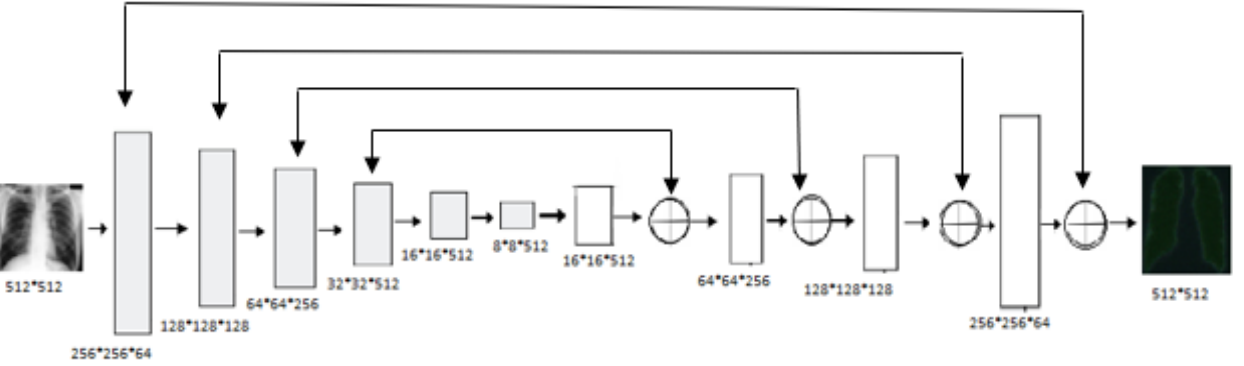
FIGURE 2 GENERATOR STRUCTURE. WE INSERT A 512 X 512-PIXEL IMAGE AFTER WHICH THE SAMPLES ARE ENCODED IN EACH DESCENDING LAYER AFTER THAT THE DECODING IS DONE. LINES SHOW SKIPPED CONNECTIONS THAT HELP MAINTAIN CONFORMATION. FINALLY, THE FINAL IMAGE IS CREATED WITH THE SAME INPUT SIZE, I.E. 512 X